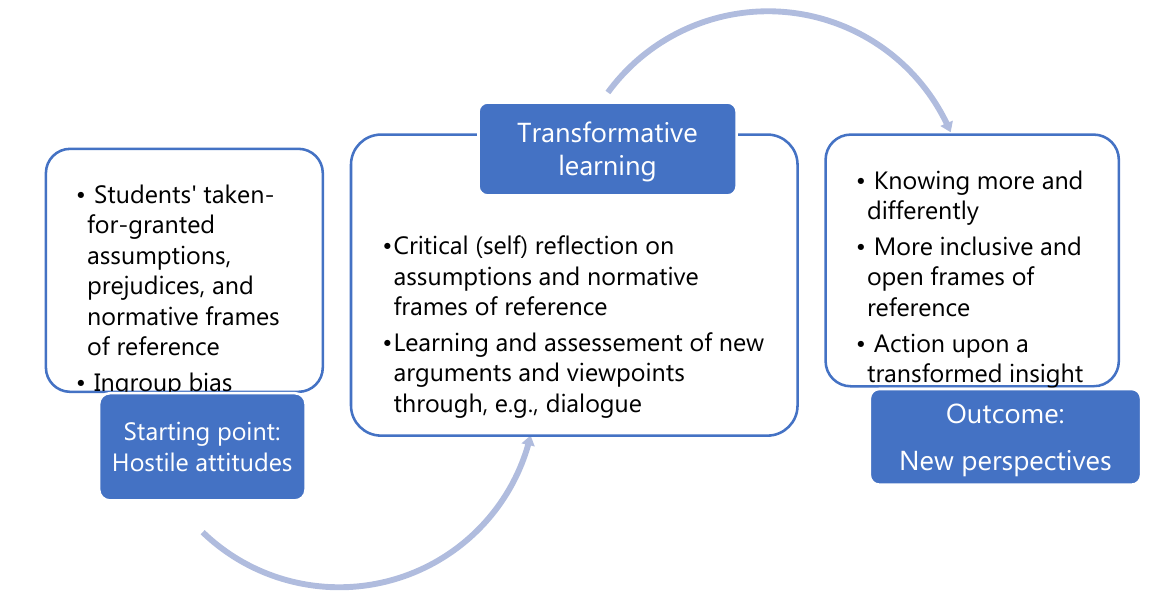
Figure 4. The process of addressing hostile attitudes in and through education.